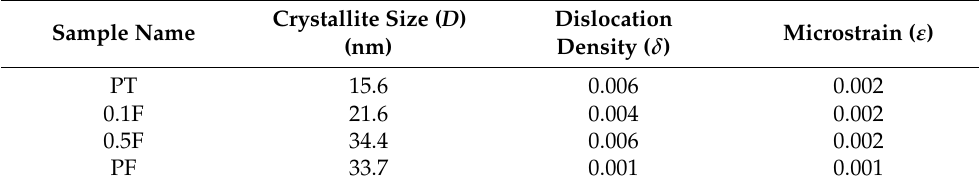
Table 1. Crystallite size ( D ), dislocation density ( δ ) and microstrain ( ε ).